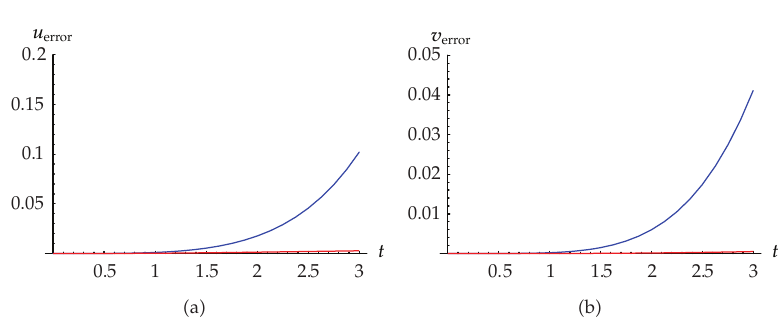
Figure 4: The absolute error curves for the the GDTM solutions (cid:4) blue (cid:5) and the GDTM-Pad´e solutions (cid:4) red (cid:5) of (cid:4) 1.2 (cid:5) when c (cid:8) − 0 . 5, d (cid:8) − 2 and n (cid:8) 1.